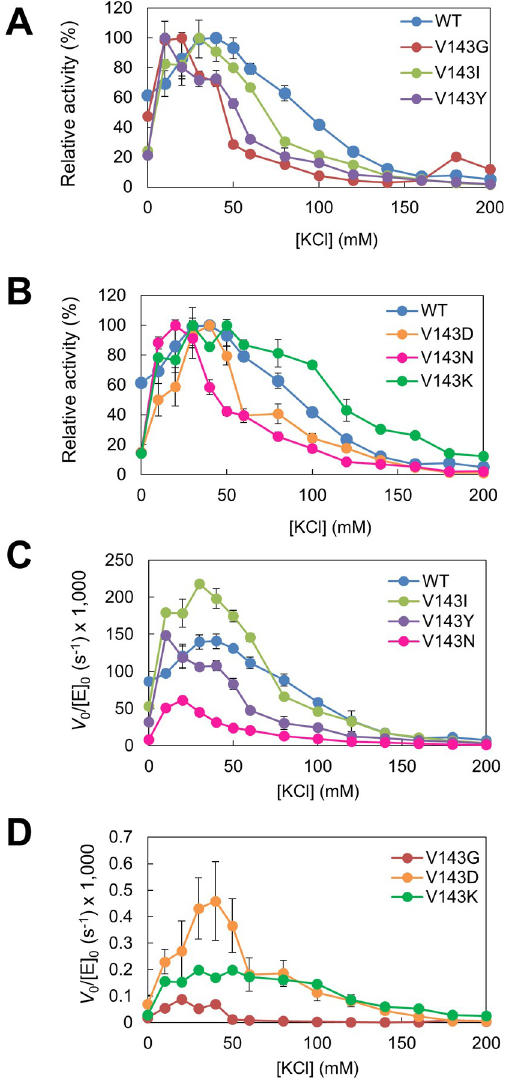
Fig 5. Dependence of activity of Val143 variants on KCl concentration for R1/D18. The reaction was carried out with 5.6 nM R1/D18 in 50 mM Tris-HCl buffer (pH 8.0), 5 mM MgCl 2 , 0–200 mM KCl at 25˚C. Relative activity (A, B), which was defined as the ratio of the activity to the highest activity, and the initial reaction rates per enzyme concentration (C, D) against KCl concentration are shown. Error bars indicate SD values of triplicate determination. The original data are in S2